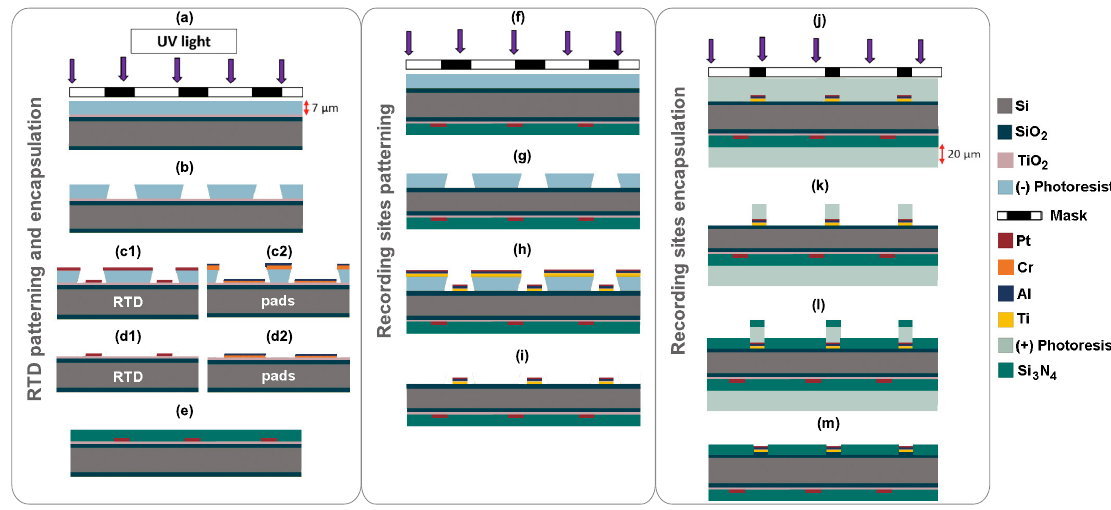
Figure 3. Cross-section view of the neural device fabrication process flow (not to scale). Table 1. Parameters of the thin-films deposition to manufacture the optrode with